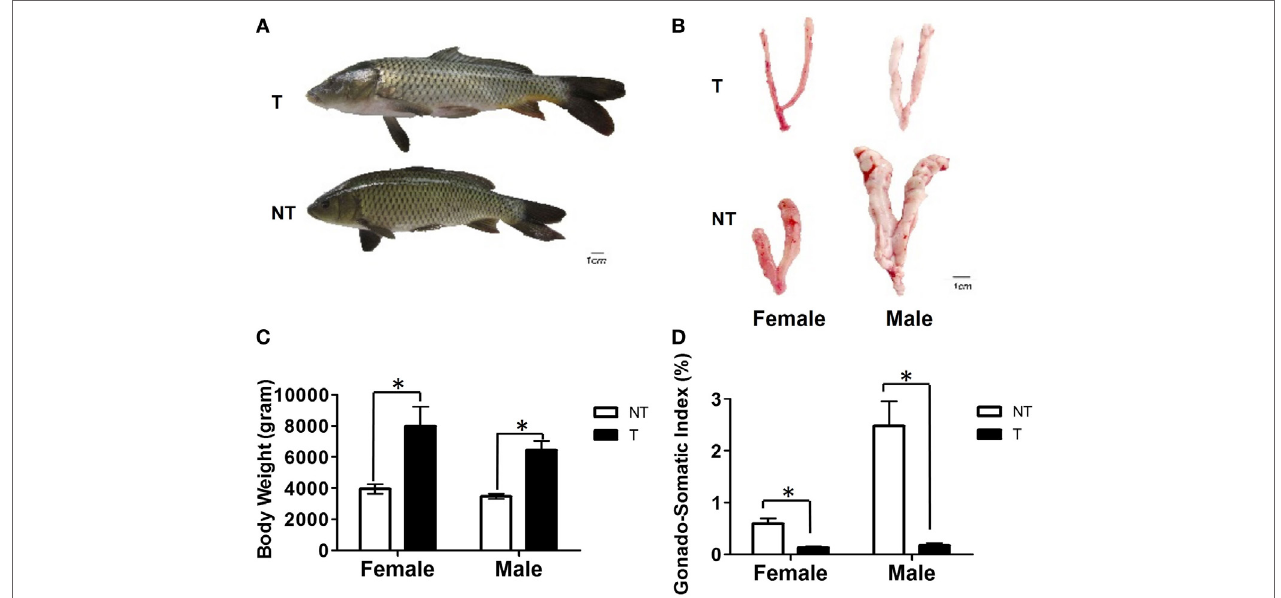
FigUre 1 | Comparison of body growth and gonadal development between non-transgenic (NT) and GH-transgenic (T) common carp of 5 months. (a) Comparison of morphology of NT and T common carp. (B) Comparison of the gonad morphology of NT and T common carp. (c) Comparison of body weight of female and male NT and T common carp. (D) Comparison of gonadal-somatic index between NT and T common carp of females and males. Samples were collected at 5 months of age. Values are represented as means ± SEM ( n = 10–15) at each sampling time and analyzed by Student’s t-test between NT and T. Asterisks indicate statistically significant differences compared within NT and T at P <